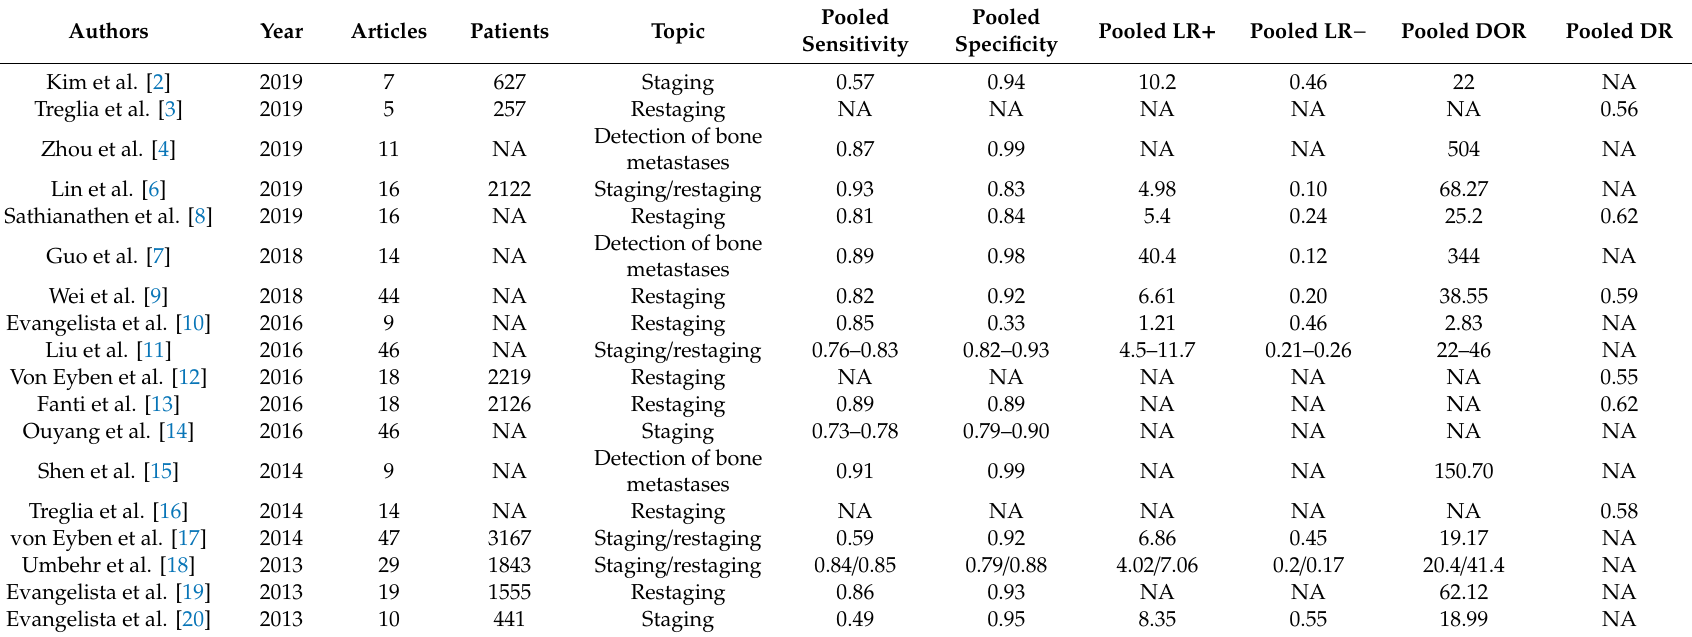
Table 1. Meta-analyses on radiolabeled choline PET / CT in prostate